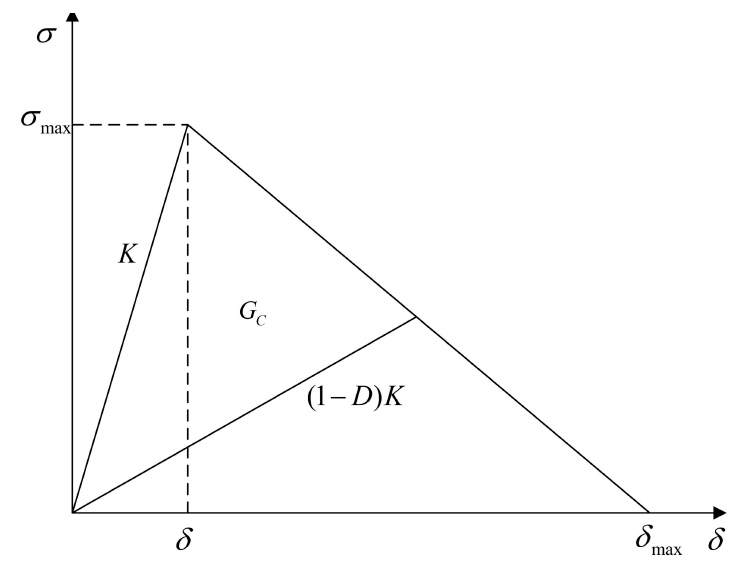
Figure 5. Bilinear CZM constitutive model .